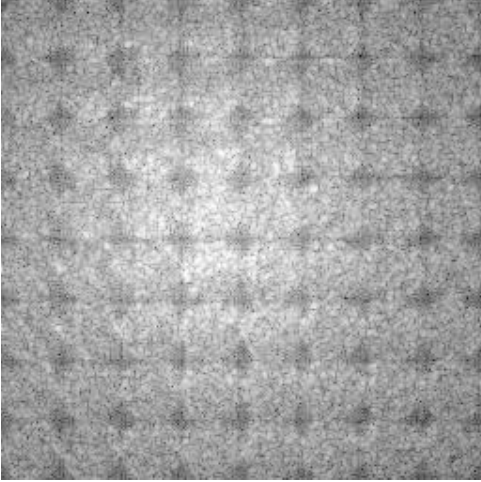
Figure 2. Section of the plenoptic frame showing the LGS on axis. The remaining, off-axis LGS present a similar